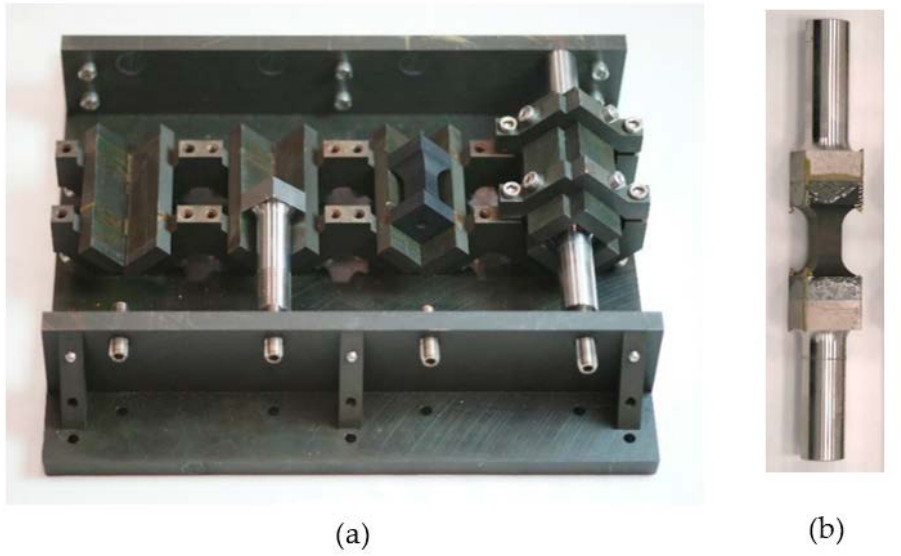
Figure 3. Images of ( a ) alignment bonding rig used for bonding end-loading bars to direct geometries, and ( b ) example of fully bonded RARDE Type III